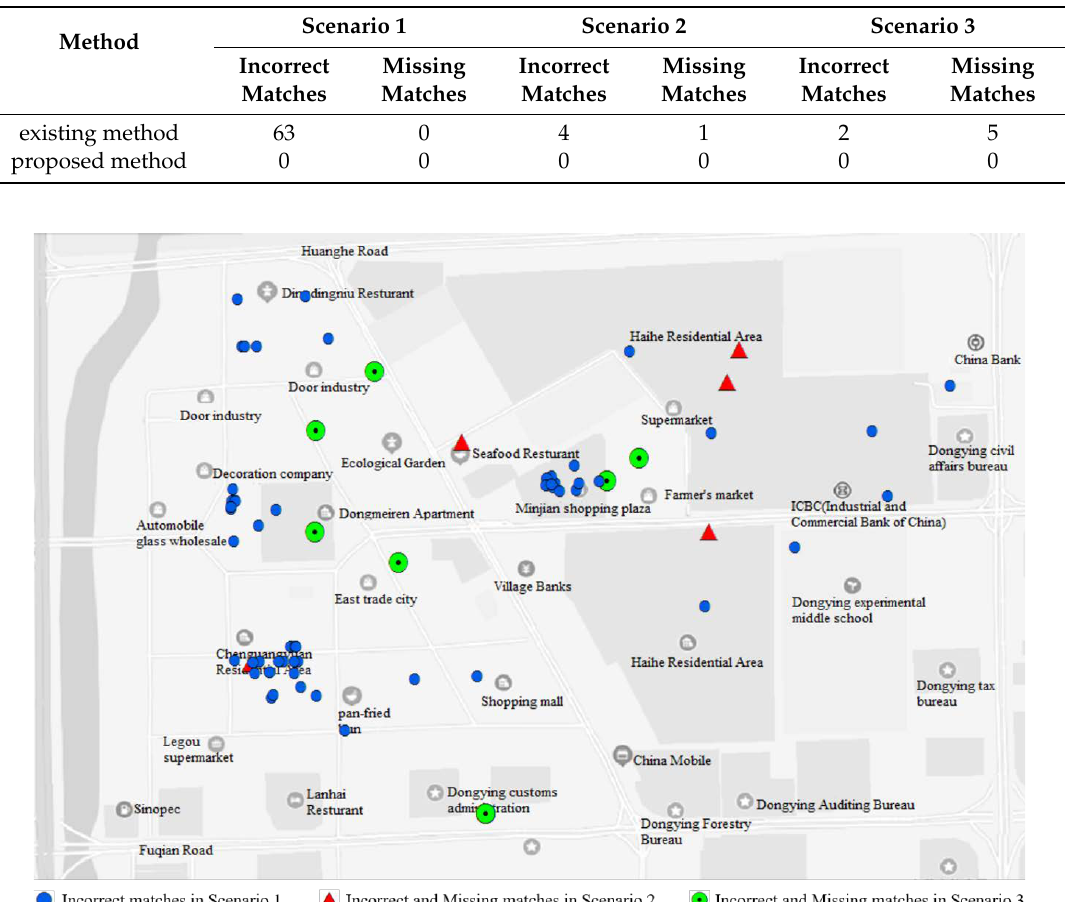
Table 2. POI matching performance under the different scenarios.